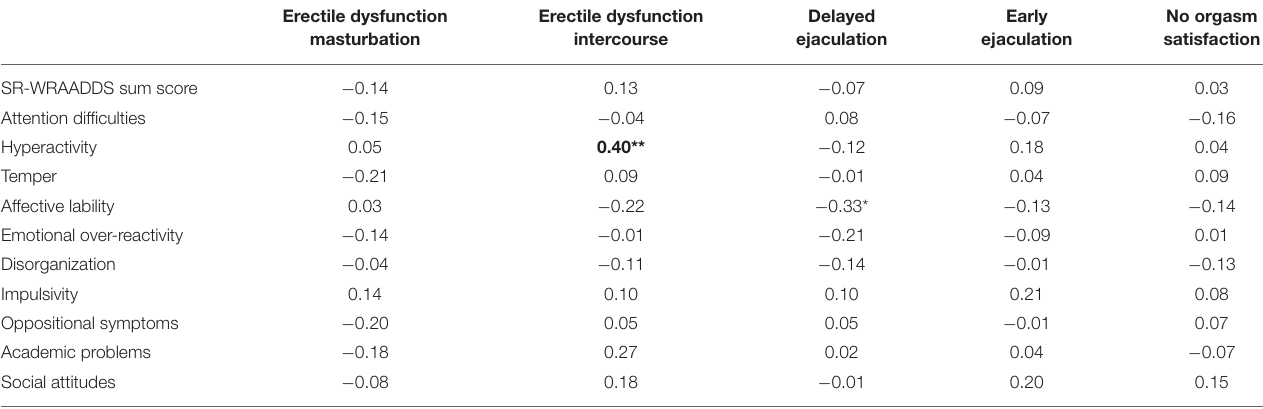
TABLE 10 | Association between ADHD symptoms and sexual dysfunctions in men with ADHD using the SR-WRAADDS and the SBQ-G. Erectile dysfunction Erectile dysfunction masturbation